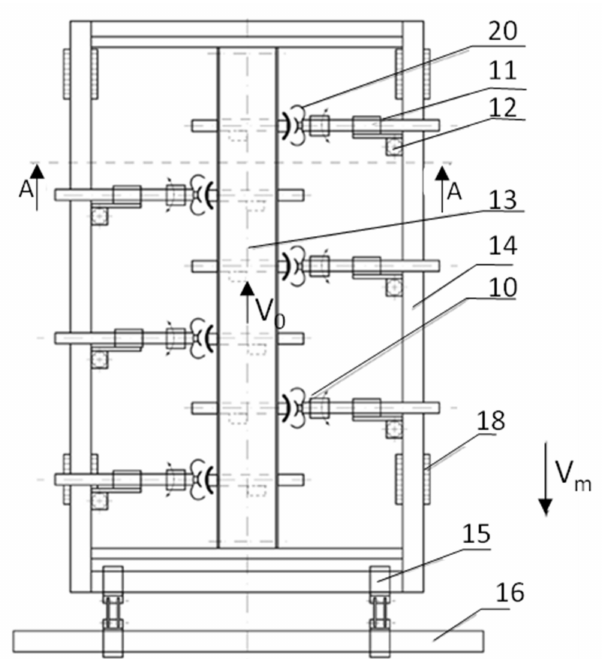
Figure 1. The working section of the harvester for harvesting strawberries, in a schematic view from above: 10—working head; 11—head arm longitudinal feed mechanism; 12—rotation mechanism in the horizontal plane; 13—belt fruit conveyor; 14—autonomous frame; 15—suspension system; 16—machine main frame; 18—tracked running gear; 20—tilting jaws; (Vm—forward speed of the combine). Source: Reprinted with permission from ref. [43]. Copyright in proceeding